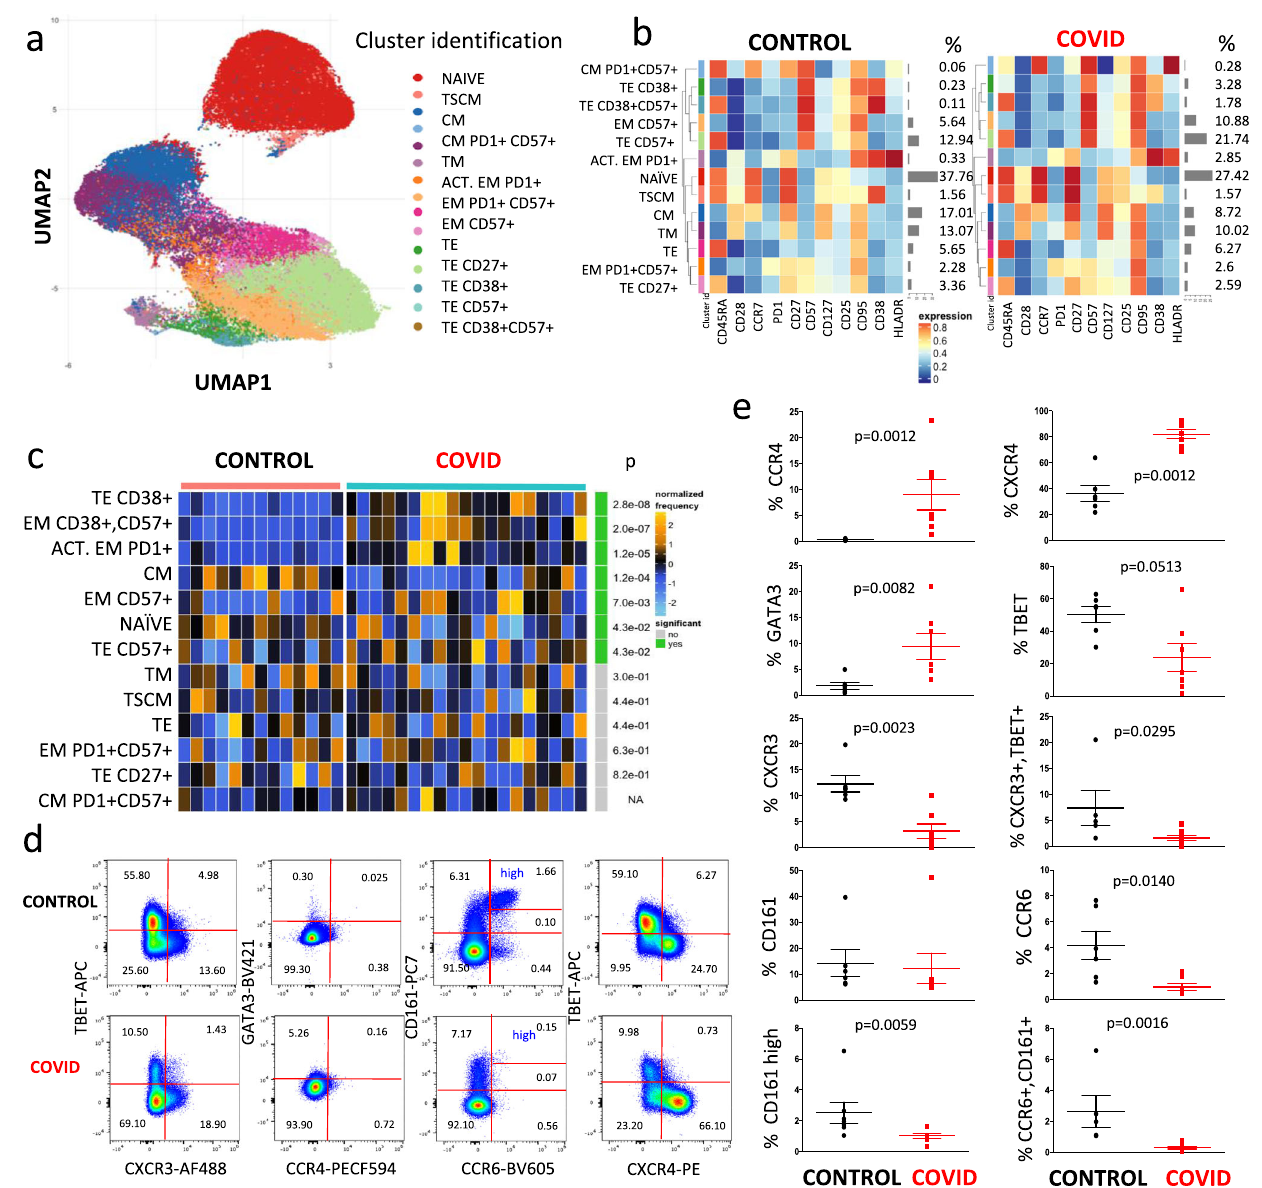
Fig. 4 Unsupervised analysis of CD8 + T cells and their characterization. a Uniform Manifold Approximation and Projection (UMAP) UMAP representation of CD8 + T cell landscape. b Heat map representing different clusters identi fi ed by FlowSOM, with relative identity and percentages in controls and patients. The color in the heat map represents the median of the arcsinh, 0 – 1 transformed marker expression calculated over cells from all the samples, varying from blue for lower expression to red for higher expression. The dendrogram on the left represents the hierarchical similarity between the metaclusters (metric: Euclidean distance; linkage: average). Each cluster has a unique color assigned (bar on the left). Barplots along the rows (clusters) and values on the right indicate the relative sizes of clusters. c Differential analysis between CTR (bar color: salmon; n = 13) and COVID-19 (emerald; n = 19). The heat represents arcsine-square-root transformed cell frequencies that were subsequently normalized per cluster (rows) to mean of zero and standard deviation of one. The color of the heat varies from blue indicating relative under-representation to orange indicating relative over-representation. Bar and numbers at the right indicate signi fi cant differentially abundant clusters (green) and adjusted p values. Clusters are sorted according to adjusted p values, so that the cluster at the top shows the most signi fi cant abundance changes between the two conditions. d Representative dot plots related to the expression of different chemokine receptors and lineage-specifying transcription factors in gated CD8 + T from a control donor (upper) and a patient (lower panel). Two experiments (one for the control group, one for patients) out of 13 are shown. Numbers indicate the percentage in each quadrant. The gating strategy for the identi fi cation of CD8 + T cells is reported in Supplementary Fig. 1. e Percentages of different CD8 + T cell subpopulations in controls ( n = 6) and patients ( n = 7), obtained by manual gating. Data represent individual values (dots), mean (centre bar) ± SEM (upper and lower bars). Statistical analysis is performed by two-sided Mann – Whitney nonparametric test; if not indicated, p value is not signi fi cant. Source data are provided as a Source Data fi